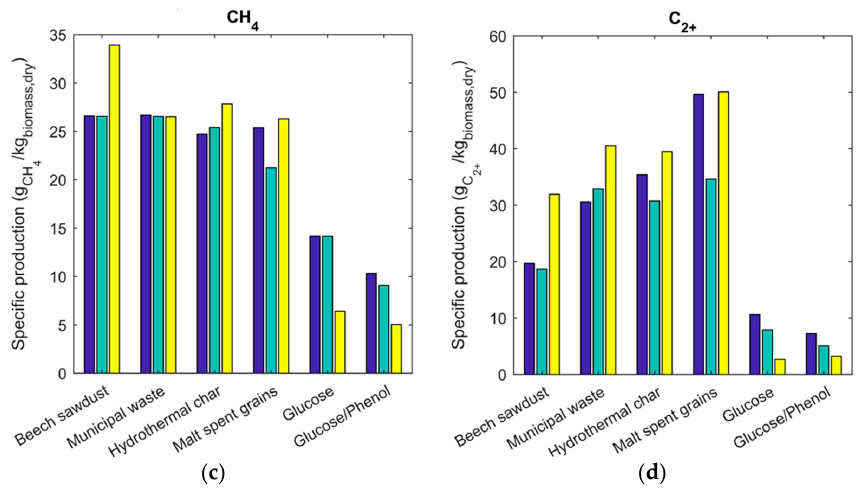
Figure 2. Specific production of gases (g GAS /kg FEED,DRY ) for the considered SCWG experiments. ( a ) H 2 ; ( b ) CO 2 ; ( c ) CH 4 ; ( d ) C 2+ .